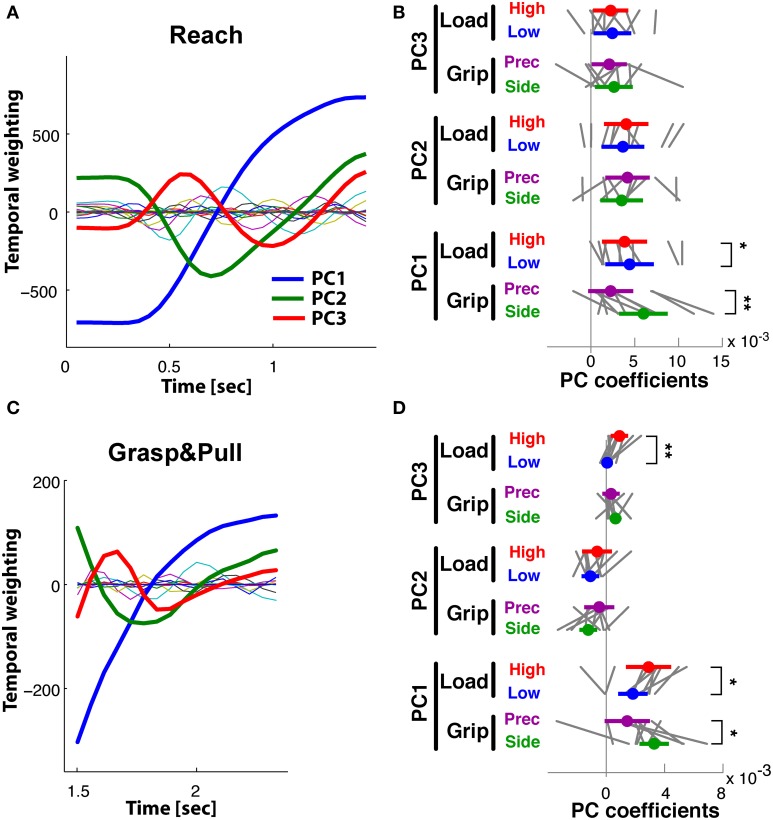
Reach period compared to grasp&pull period: PCA on time-varying kinematics. (A,B)
Reach period. (C,D)
Grasp&pull period. (A)
Reach: temporal weighting for the first three PCs (thick lines) and the other PCs. (B)
Reach: Average PC coefficients (colored dot) and ±95% confidence interval (colored horizontal bar) per PC and task condition, and corresponding averages for each subject (thin gray lines). Significant difference in average PC coefficients on PC1 for grip type and load condition. (C)
Grasp&pull: temporal weighting for the first three PCs (thick lines) and the other PCs. (D)
Grasp&pull (scheme as in B): significant difference in average PC coefficients on PC1 for GRIP, and on PC1 and PC3 for LOAD. *, ** Indicate significant difference at p < 0.05 and p < 0.01, respectively.